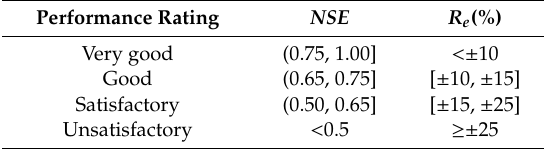
Table 4. The Moriasi performance rating scheme in watershed streamflow